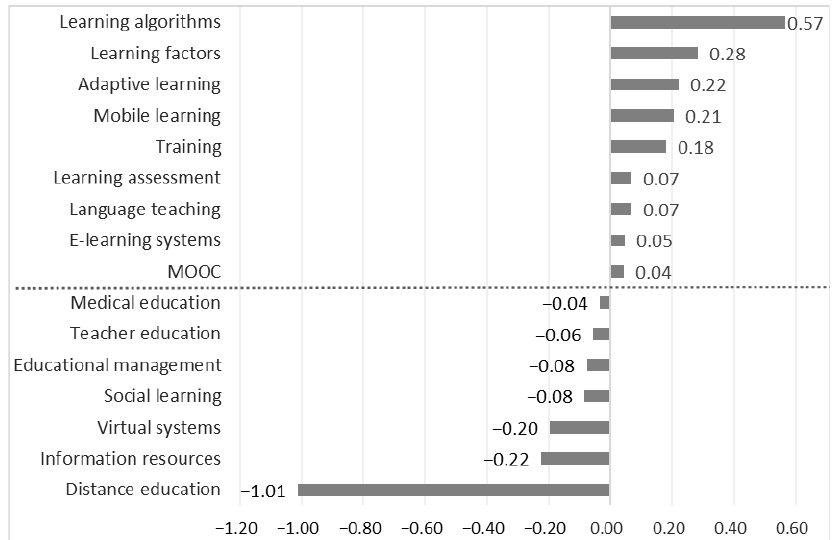
The recent trends of the topics and their acceleration values during the last period (2016–2019) are given in Figure 7. “Learning algorithms” had a significantly higher acceleration (1.21), and during the same period, the acceleration of the topics “e-learning systems” ( − 0.33) and “distance education” ( − 0.31) was the